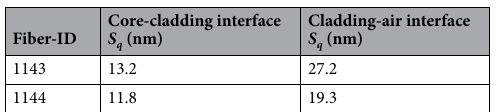
Table 2. Values of interface roughness, used for simulation of bent fibres.